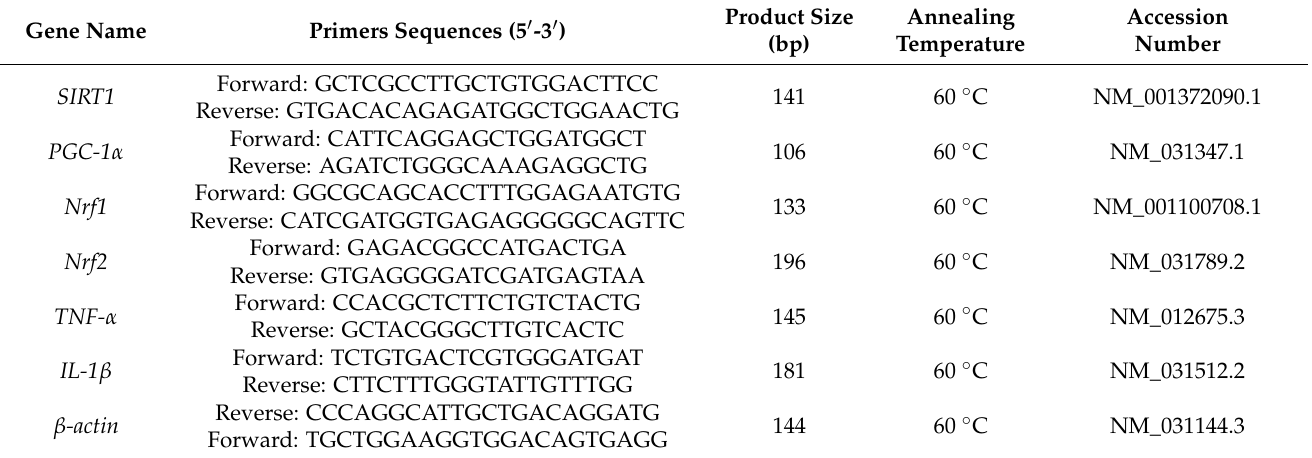
Table 1. Primer sequences for quantitative RT-PCR